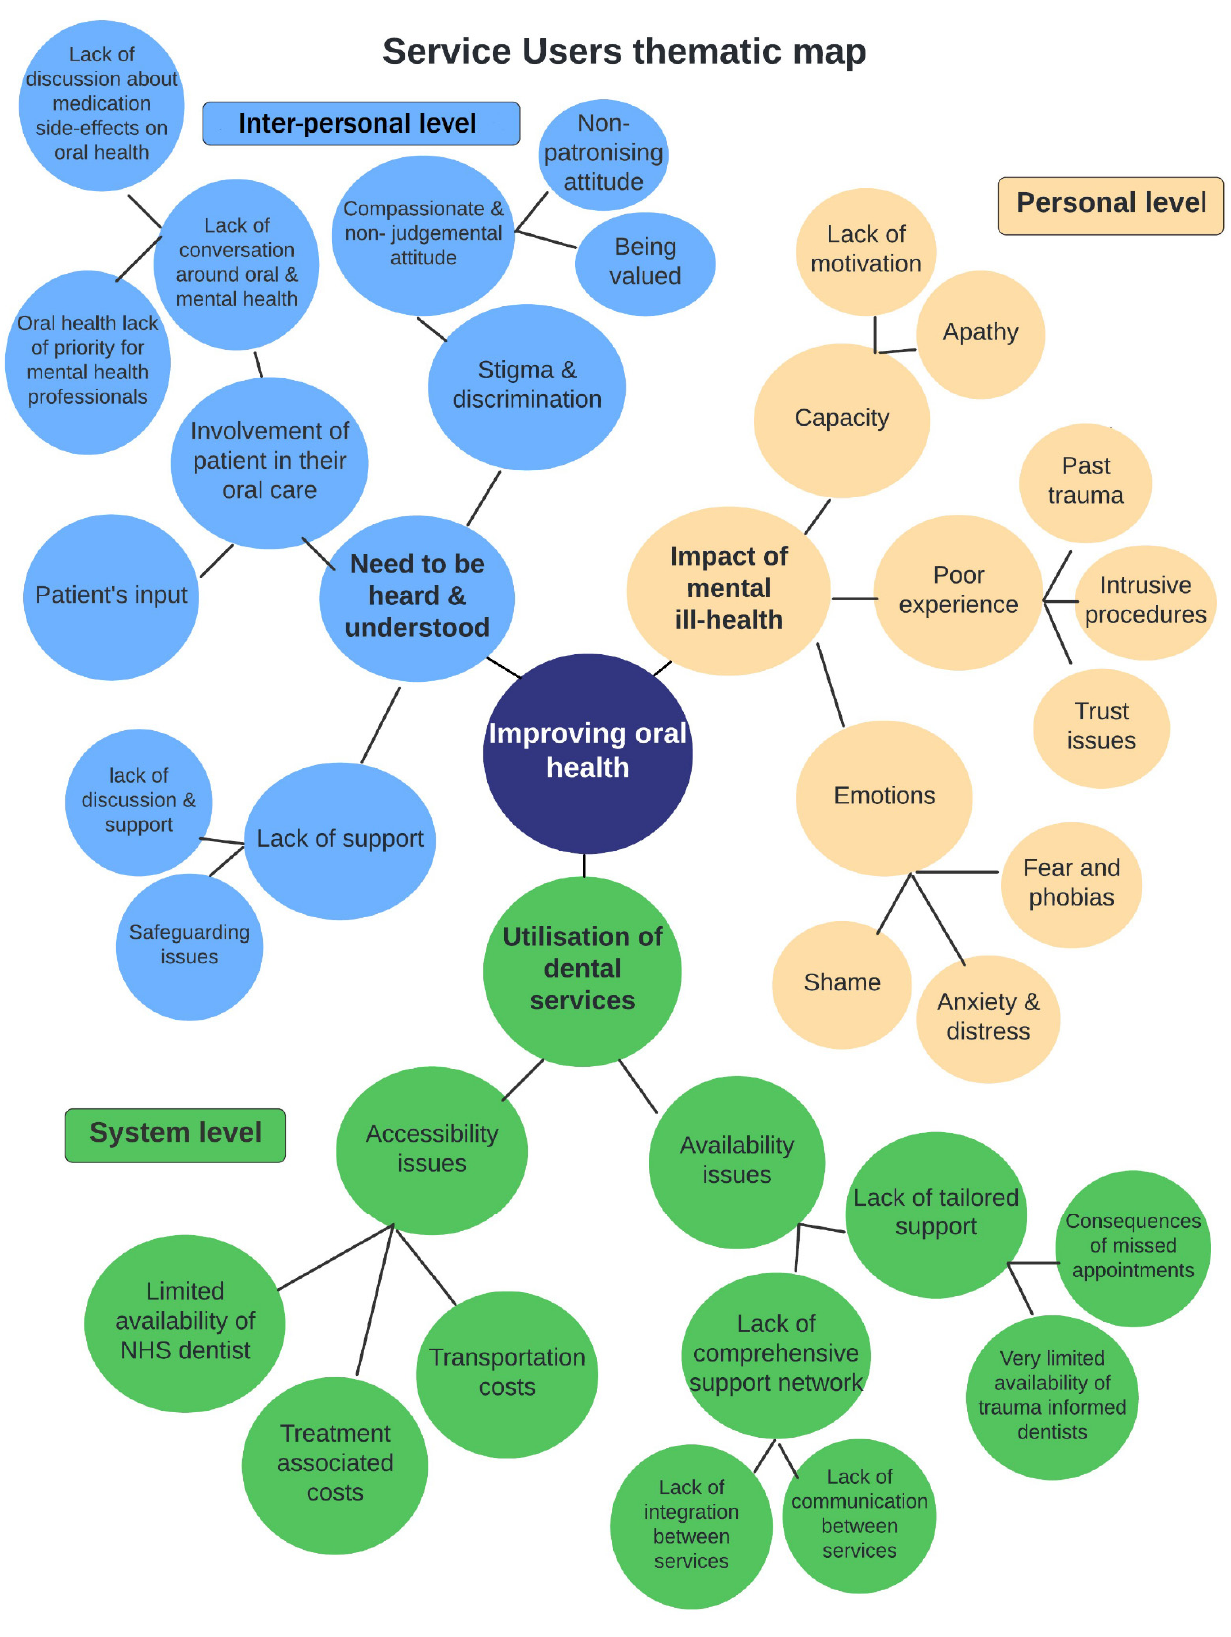
Figure 1. Thematic map of service users’ perspectives on barriers to improving oral health in people with severe mental illness at personal, inter-personal and system levels.